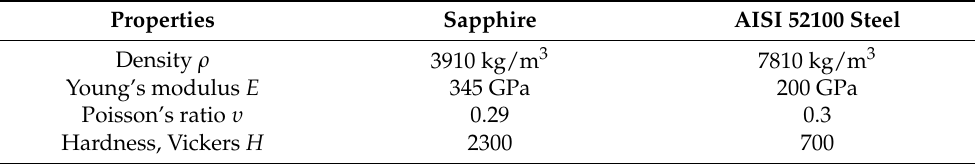
Figure 3. Experimental setup of the reciprocating sliding tests: ( a ) homemade reciprocating sliding friction test platform; ( b ) sapphire half ball; ( c ) sphere-flat contact. Table 2. Physical properties of sapphire (Al 2 O 3 ) and AISI 52100 steel at room temperature.